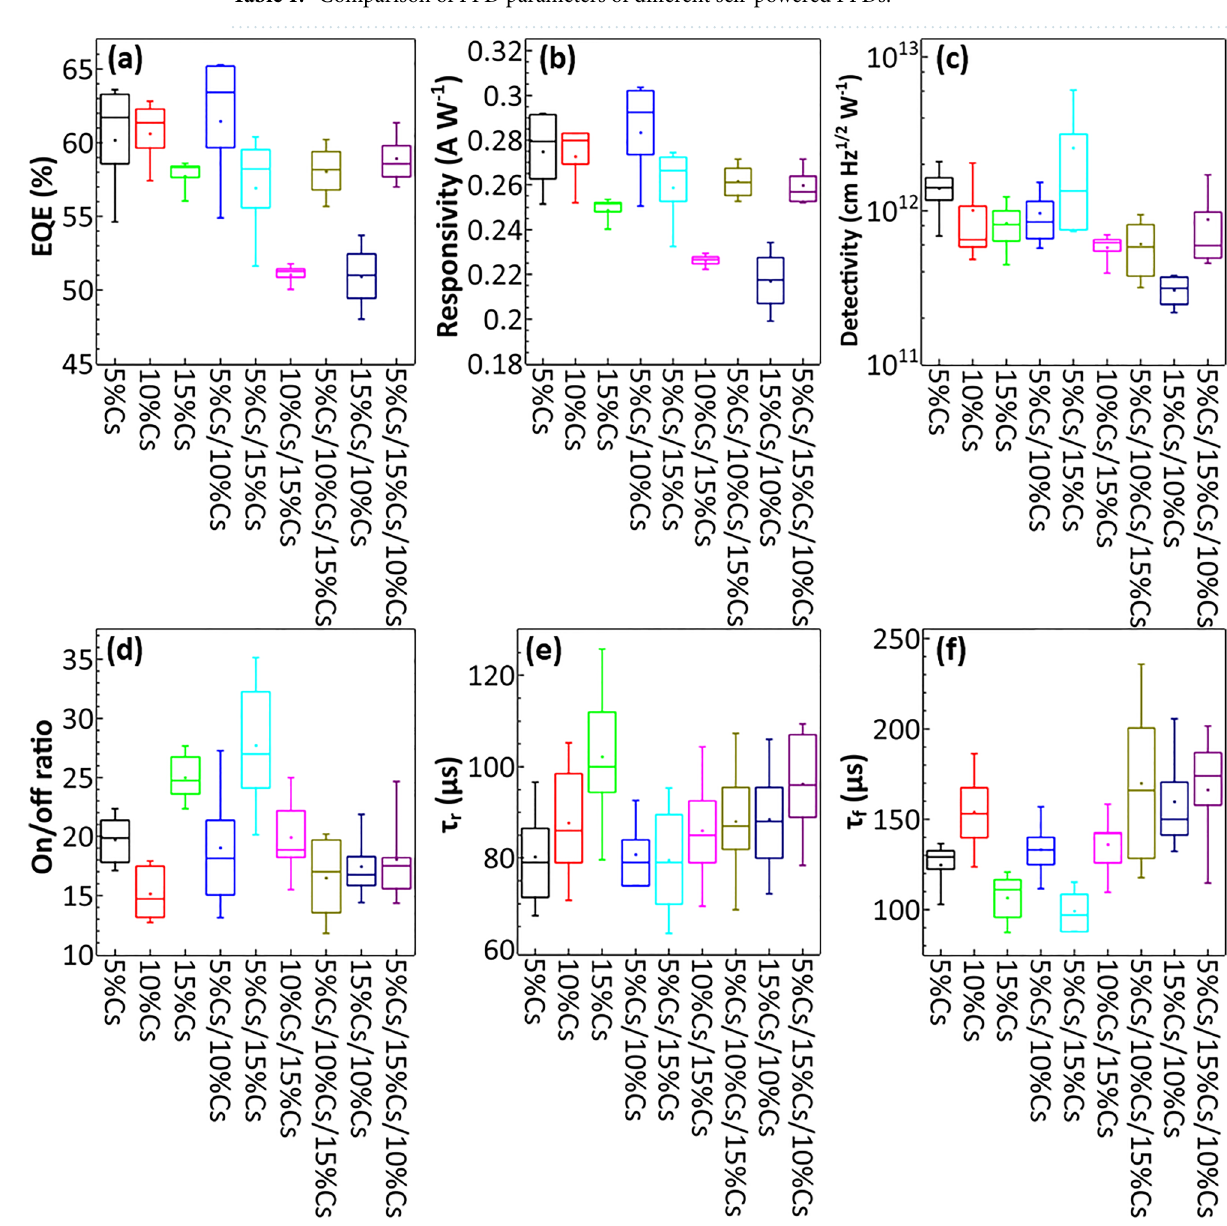
Figure 4. ( a ) EQE at 550 nm, ( b ) Responsivity at 600 nm, and ( c ) Specific detectivity at 550 nm of single, double, and triple-layer PPDs. ( d ) On/off ratio of single, double, and triple-layer PPDs. ( e ) Rising time (τ r ) measured from 10 to 90% of maximum photocurrent of single, double, and triple-layer PPDs. ( f ) Falling time (τ f ) measured from 90 to 10% of the maximum photocurrent of single, double, and triple-layer